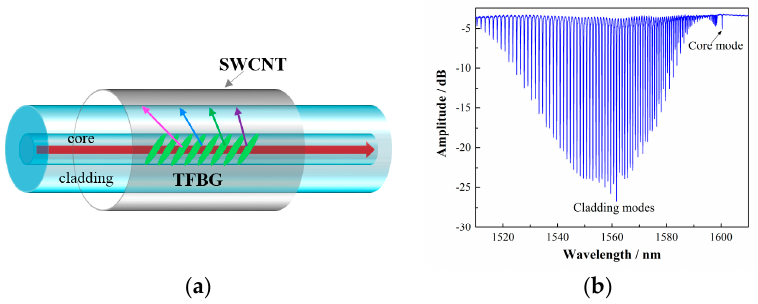
Figure 1. ( a ) Schematic diagram of the wind speed sensor; ( b ) spectrum of a common TFBG. TFBGs are a special kind of fiber Bragg grating, where the gratings are tilted with respect to the fiber axis and can couple light from the core to the cladding.